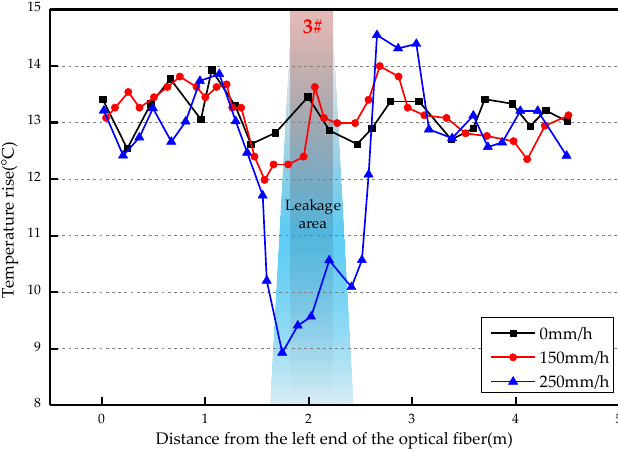
Figure 15. Temperature rise curve at different seepage flow velocity at 12 W.